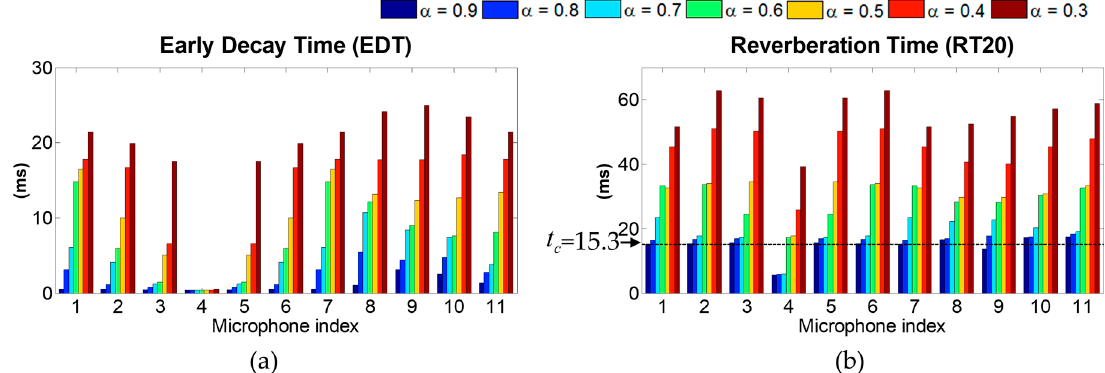
Figure 11. ( a ) Early decay time and ( b ) reverberation time according to change in α based on the finite-difference time-domain (FDTD) simulation.